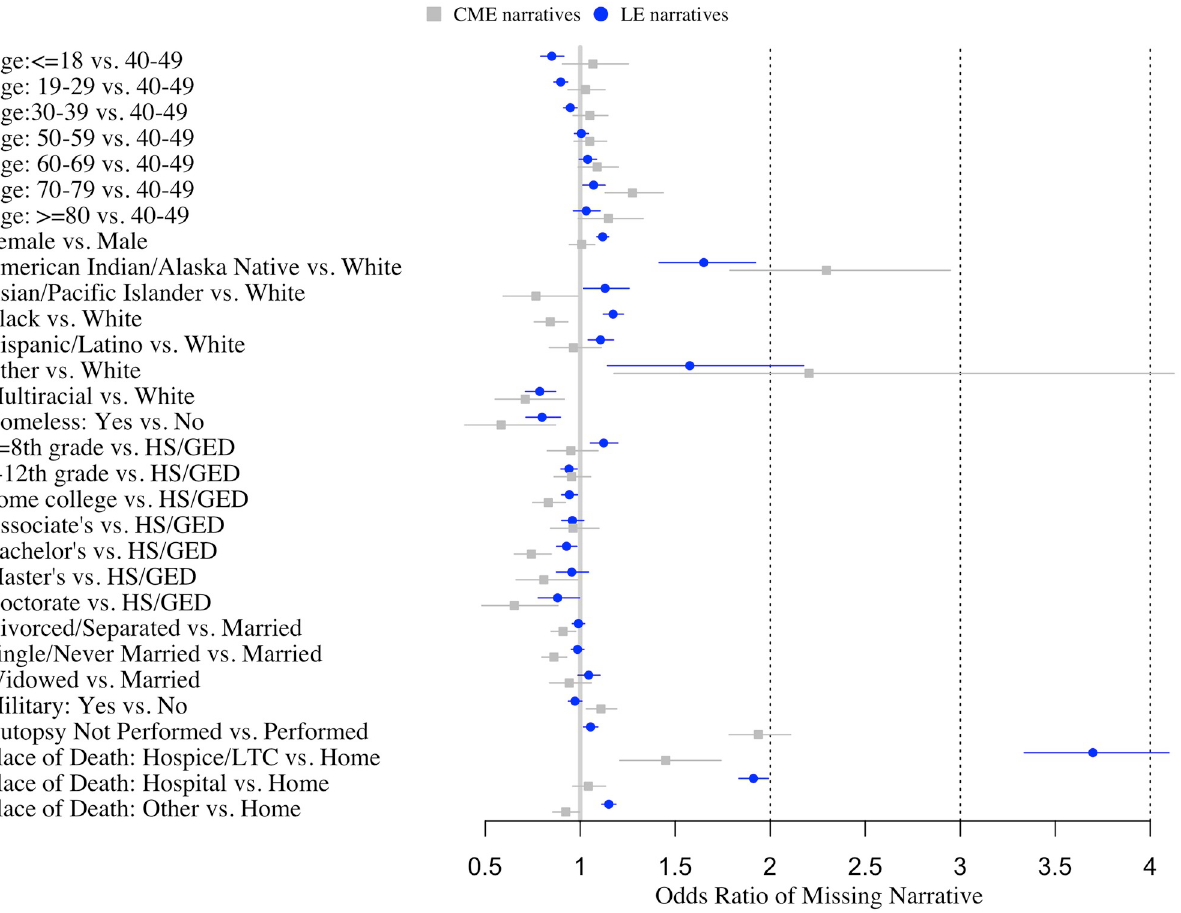
Fig 2. Forest plot of relative odds (95% confidence intervals) of missing C/ME and LE narrative texts associated with decedent characteristics, NVDRS 2003–2017. Estimates are adjusted for all variables show in the figure as well as year, location of death, and autopsy status and account for clustering within site using GEE with robust standard